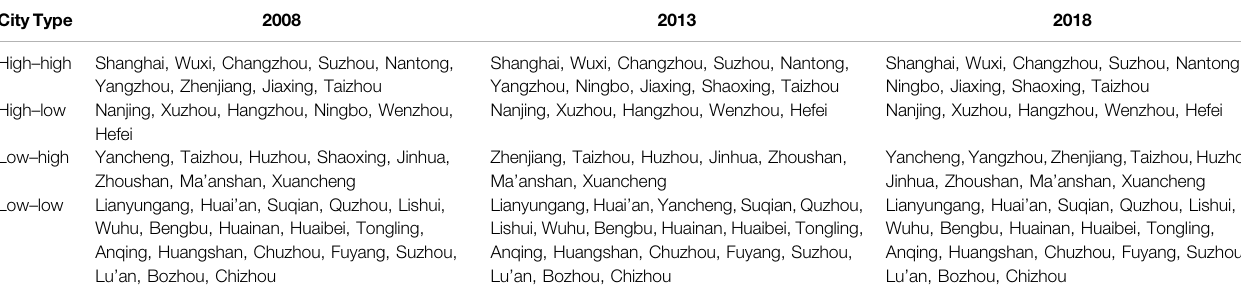
TABLE 4 | Types of the spatial distribution of coupling coordination in the Yangtze River Delta in 2008, 2013, and